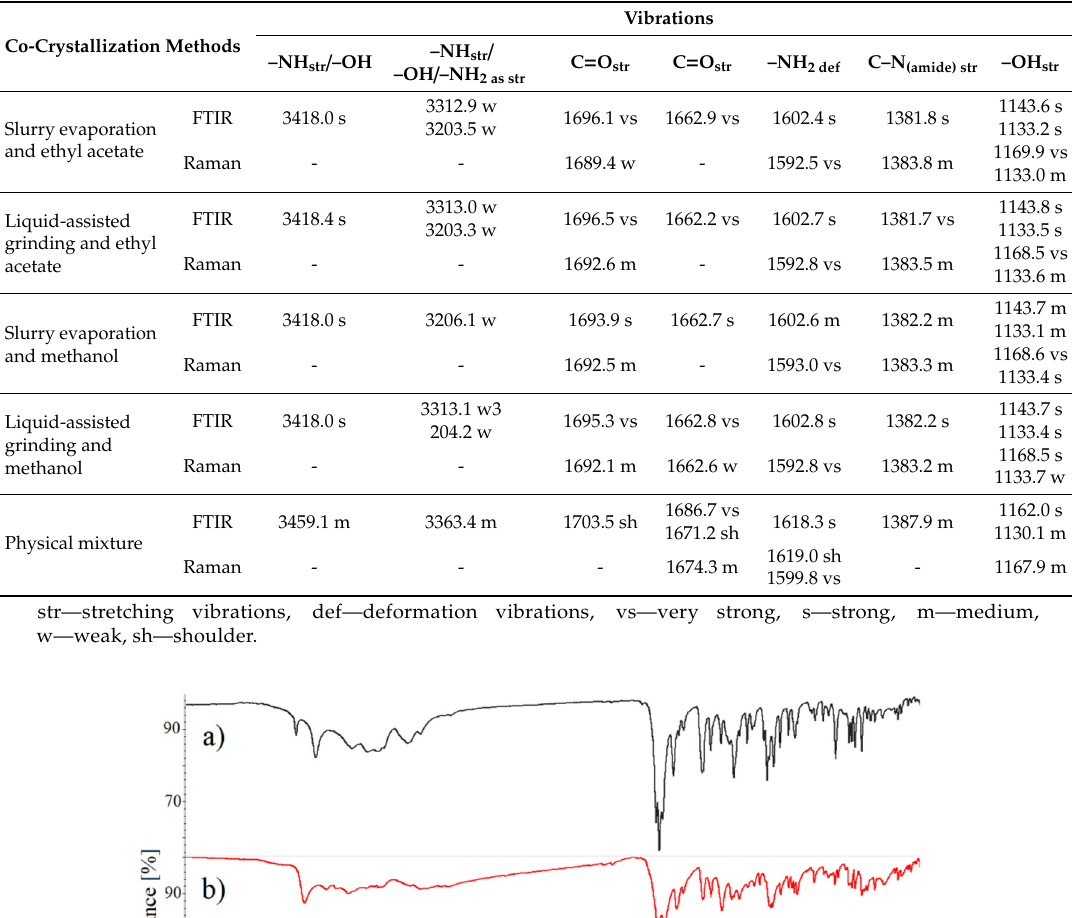
Table 6. Characteristic FTIR and Raman bands of lorazepam co-crystals with nicotinamide prepared using different co-crystallization methods and solvents. using di ff erent co-crystallization methods and solvents.